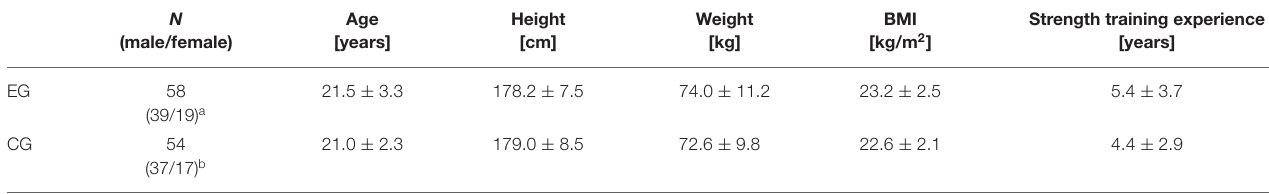
TABLE 1 | Anthropometric data (mean